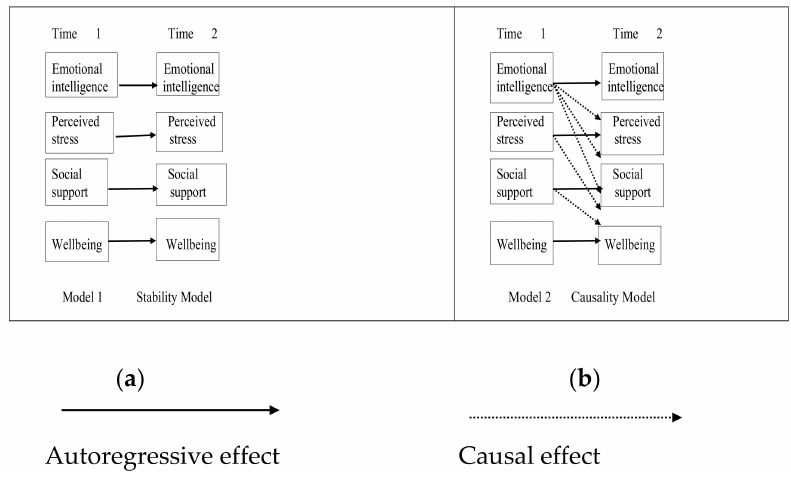
Figure 2. The path model used to assess and examine the path models: ( a ) represents the stability model; ( b ) is an outline of the causality